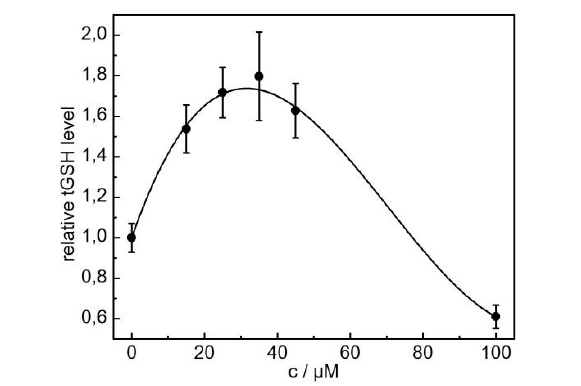
GSH levels increase in HaCaT cells following exposure to 15, 25, 35, 45 and 100 µM CdCl for 6 h [mean ± SE; n = 3]. The curve was fitted to the experimental data using a 2 polynomial regression